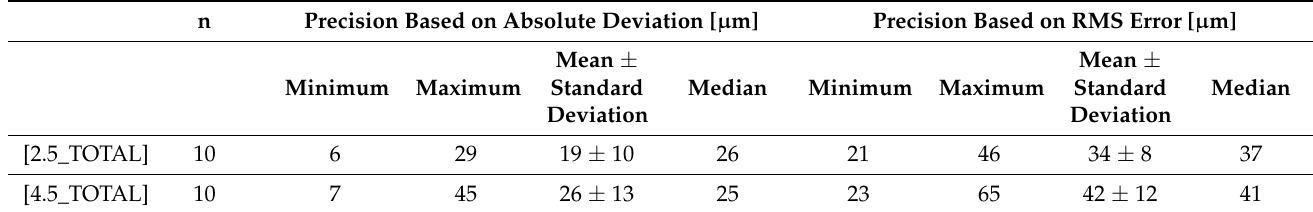
Table 5. Precision [2.5_TOTAL] and [4.5_TOTAL].